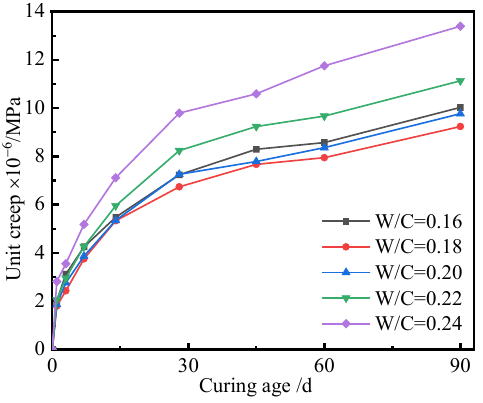
Figure 4. Creep curves of the UHPC with different W/C values.